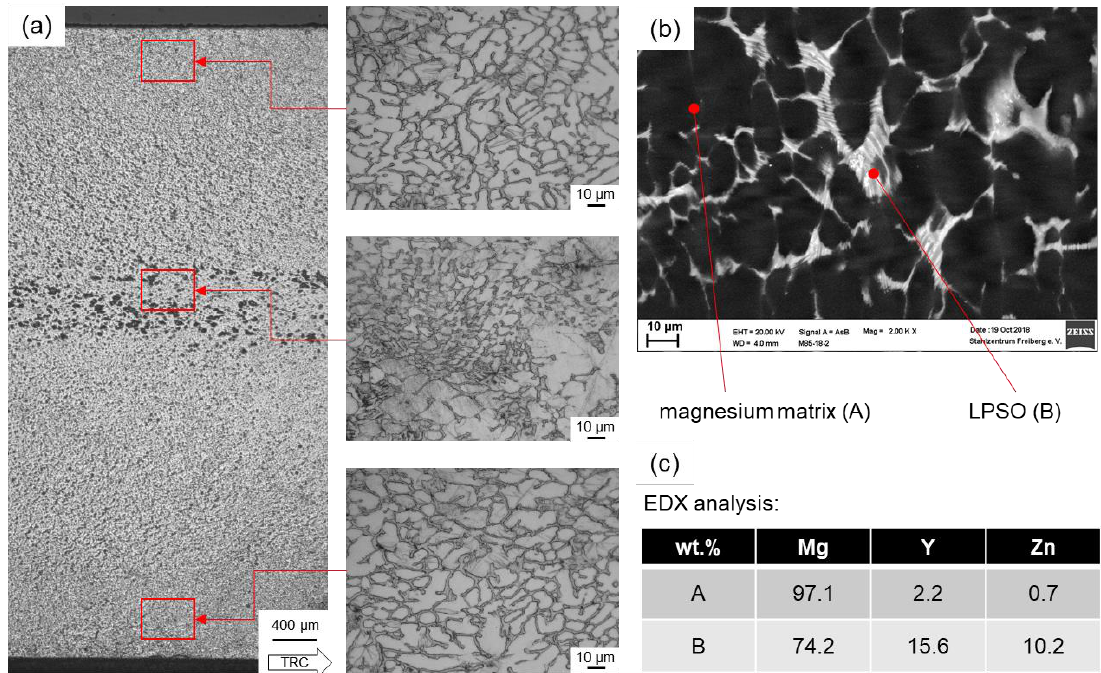
Figure 1. ( a ) Optical and ( b ) scanning electron microscopy (SEM) micrograph (at mid-thickness) of the microstructure of the twin-roll cast (TRC) state of the WZ73 magnesium alloy and ( c ) hemical composition of microstructural constituents (A—magnesium matrix, B—LPSO) determined by means of energy dispersive X-ray spectroscopy (EDX)-analysis.